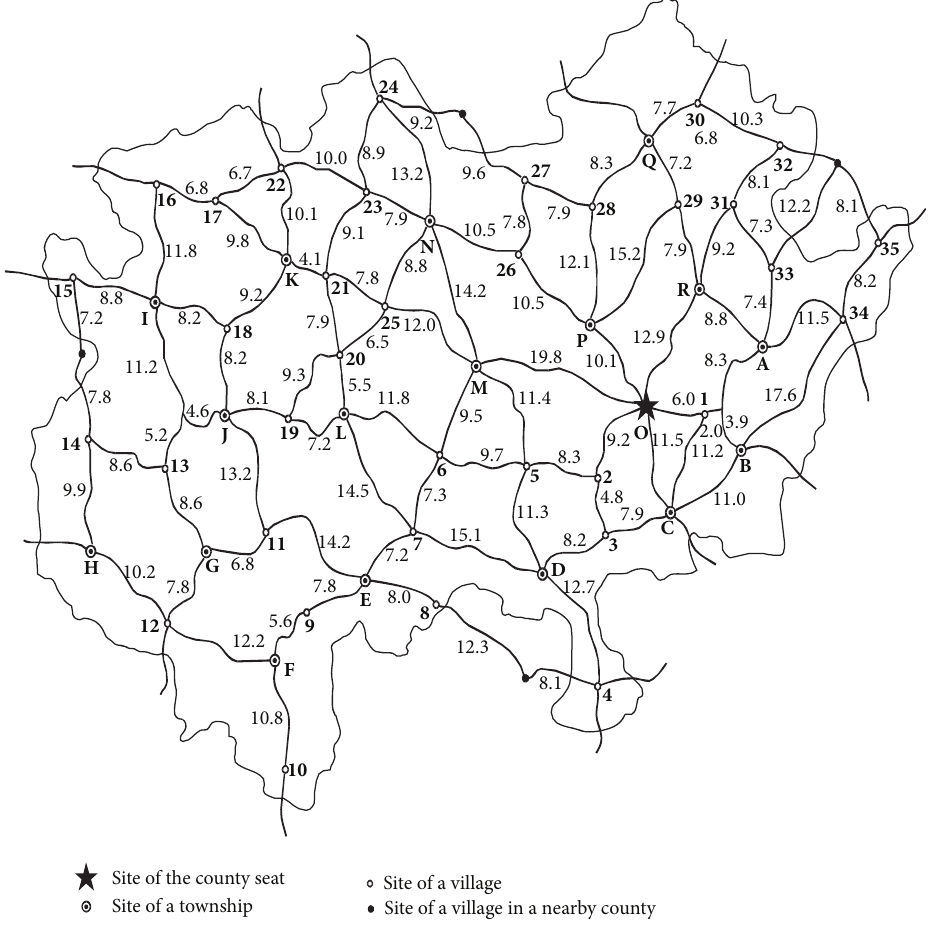
Figure 1: The sites in the case study.